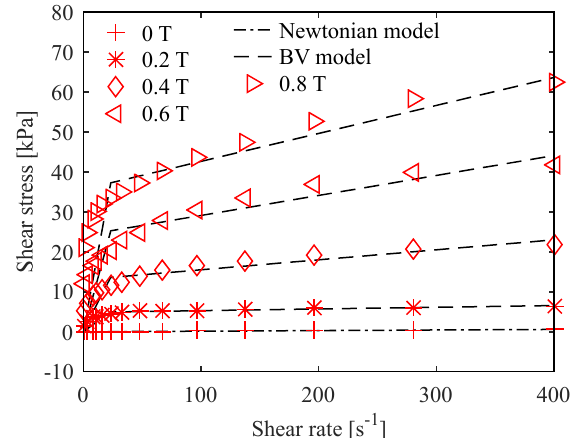
Figure 4. Rheological behavior of MR fluid.